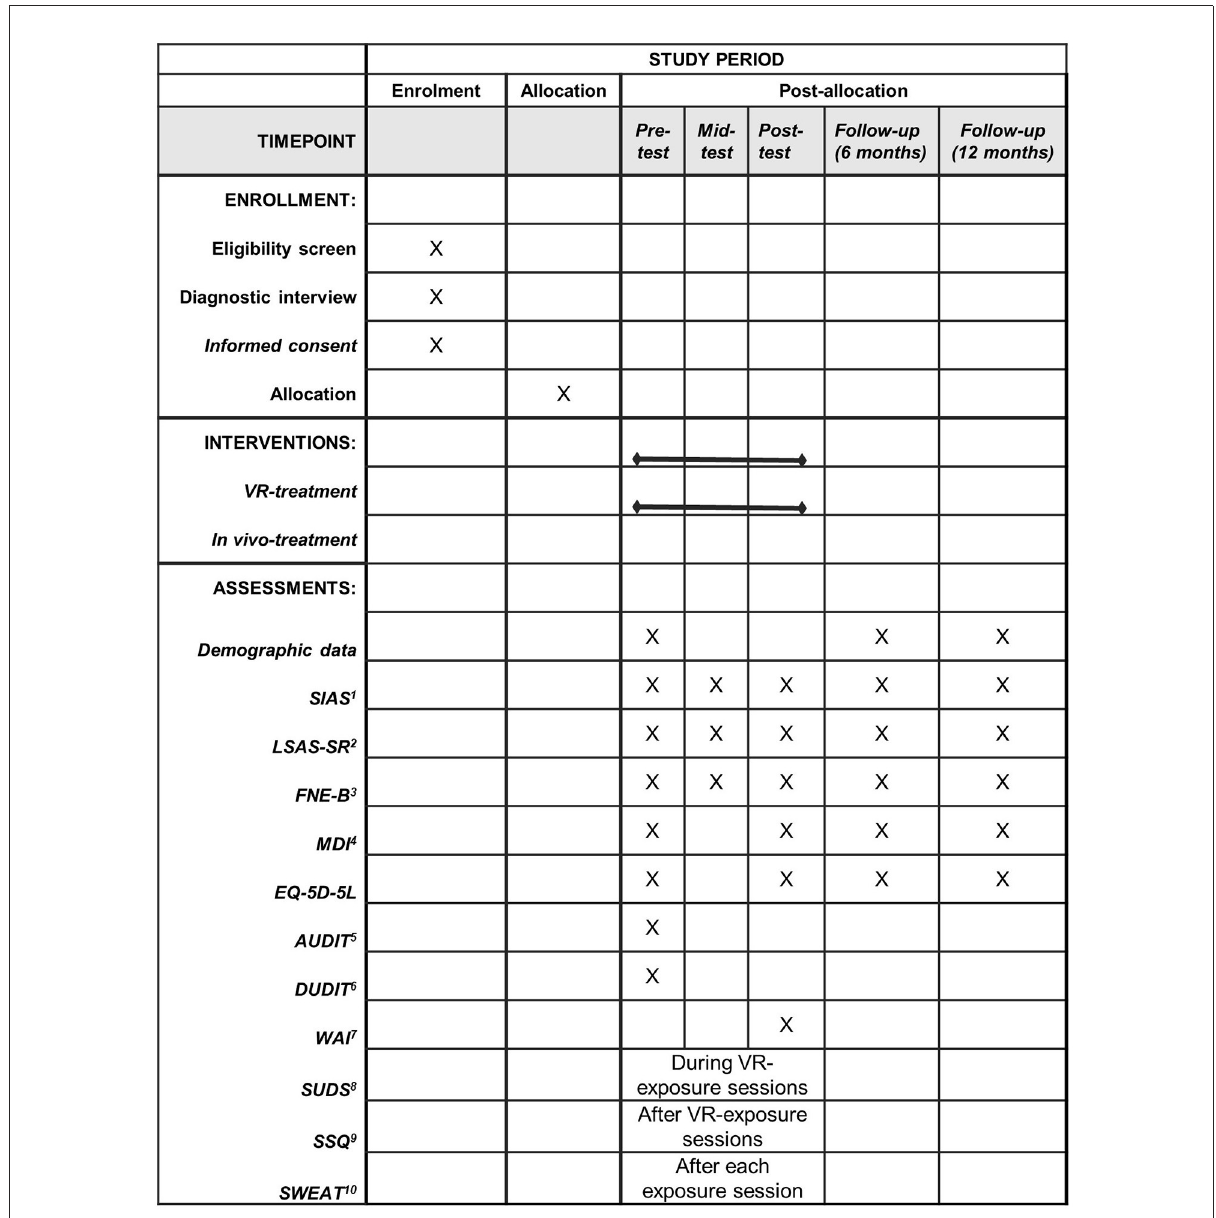
FIGURE2 Schedule of enrollment, interventions, and assessments. 1 SIAS, Social Interaction Anxiety Scale; 2 LSAS-SR, Leibowitz Anxiety Scale-Self report version; 3 FNE-B, Fear of Negative Evaluation-Brief version; 4 MDI, Major Depression Inventory; 5 AUDIT, Alcohol Use Disorders Identification Test; 6 DUDIT, Drug Use Disorders Identification Test; 7 WAI, Working Alliance Inventory; 8 SUDS, Subjective Units of Distress Scale; 9 SSQ, Simulator Sickness Questionnaire; 10 SWEAT, Specific Work for Exposure Applied in